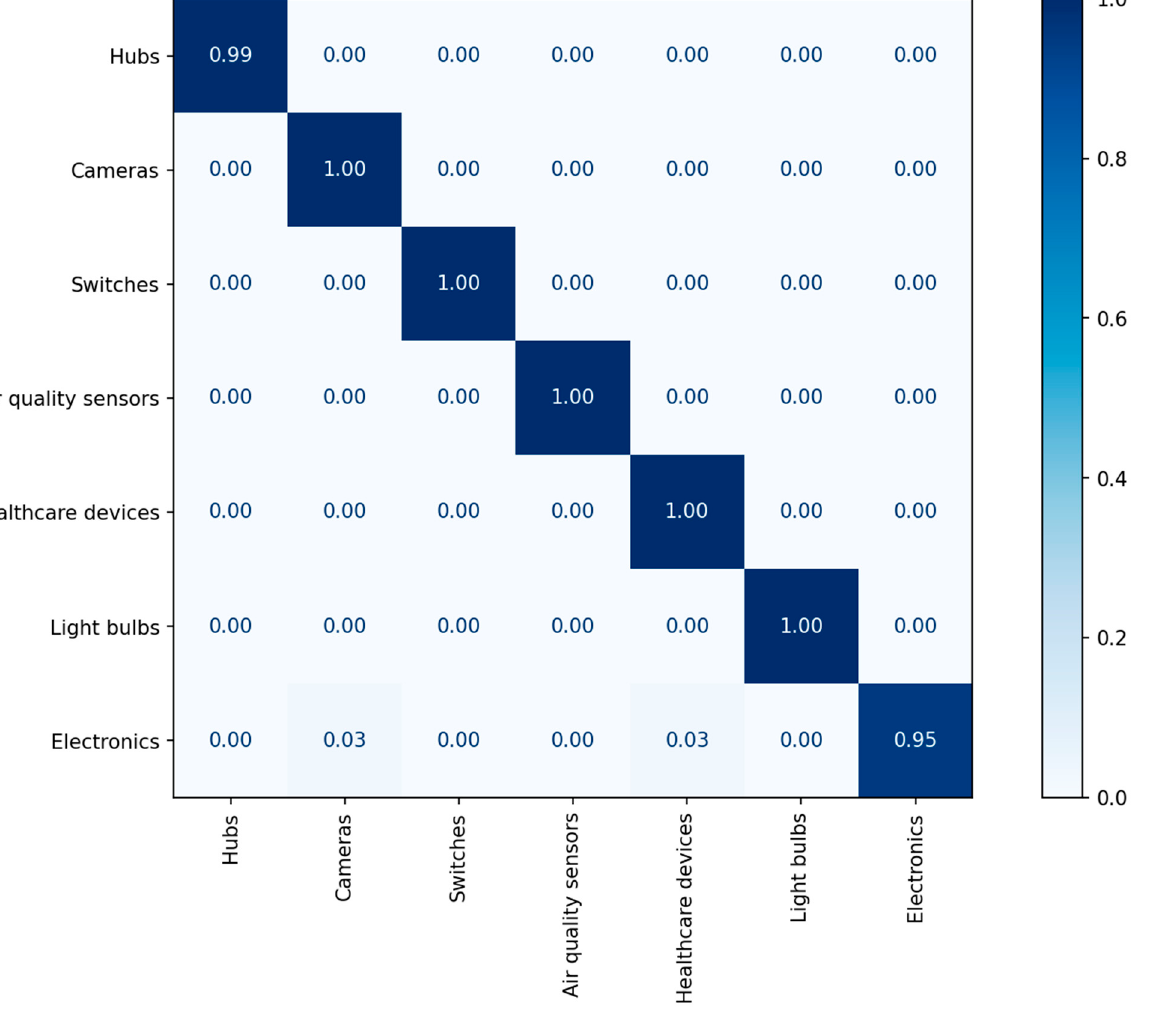
Figure 4. The confusion matrix of the classification results for category identification.